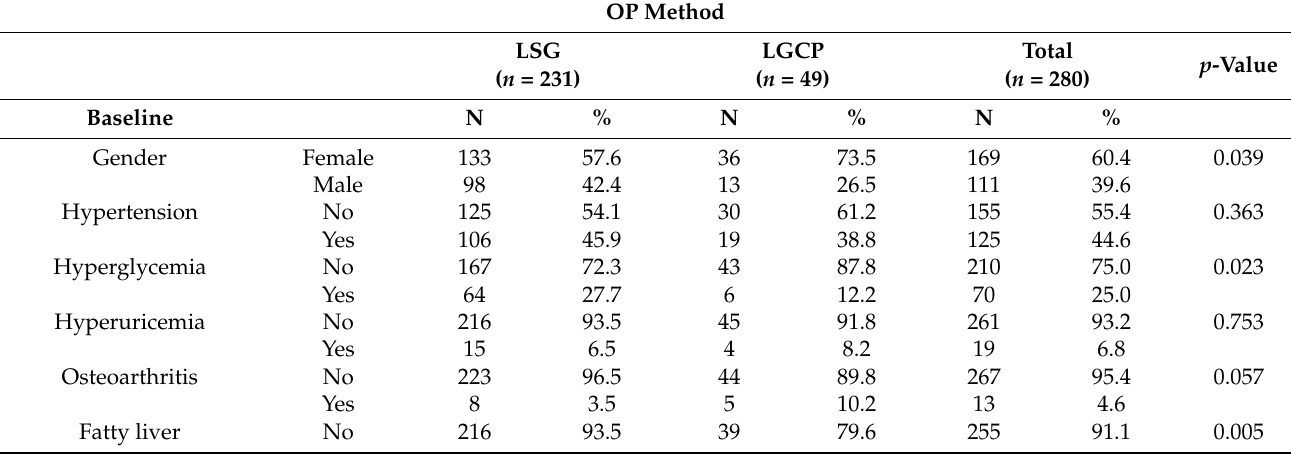
Table 2. Demographic characteristics of the health profile of the patients in this